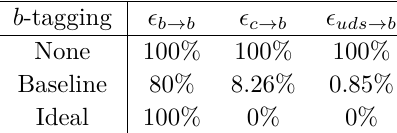
Table 9 . Parameters of three b -tagging conditions. Symbols (cid:15) b → b and (cid:15) udsc → b represent the b -jet tagging efficiency and the background-jets mistagging rates, respectively. Signal